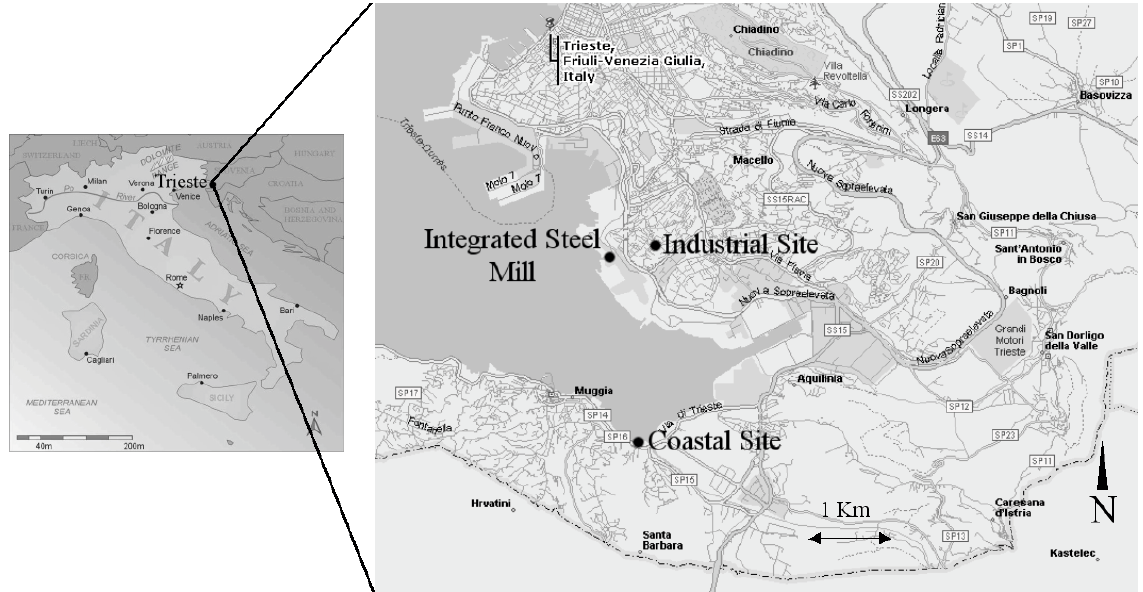
Figure 1. Map of Trieste and the surroundings, showing the locations of two sampling sites and the integrated steel